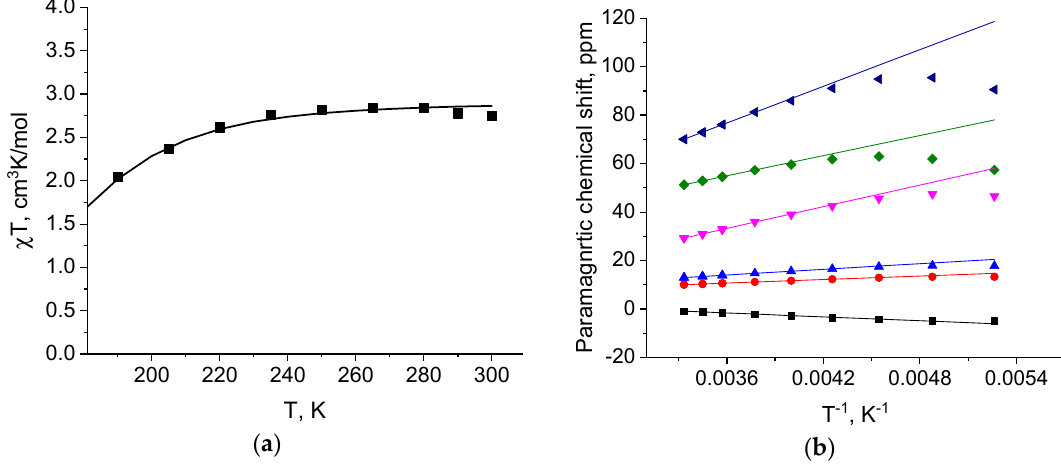
Figure 7. ( a ) Variable-temperature magnetic susceptibility data for the solution of [Fe( L ) 2 ](BF 4 ) 2 in dichloromethane-d 2 according to the Evans method; the line corresponds to the best fit by a regular solution model [33], and ( b ) paramagnetic chemical shifts plotted versus 1 / T (bottom); the lines represent the linear fit over the temperature range 280–300 K. Table 3. Spin-crossover (SCO) parameters 1 from the NMR data for a dichloromethane-d 2 solution of